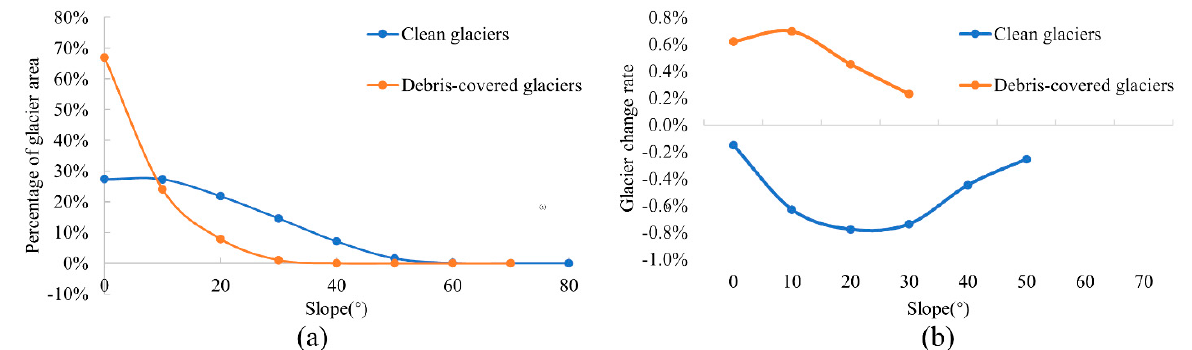
Figure 8. Changes in glacier area at different elevations on the Tibetan Plateau. ( a ) Percentage of area and ( b ) average annual rate of change at different elevations.